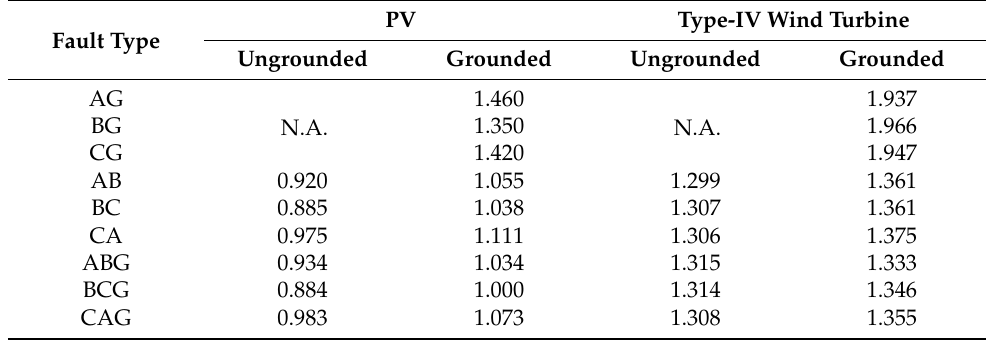
Figure 16. K - factor when AB fault is applied and PV plant is connected: ( a ) voltage dip depth in positive ( Fault deep U1 ) and negative ( Fault deep U2 ) sequences; ( b ) reactive current in each phase ( Ir_Phase A , Ir_Phase B and Ir_Phase C ) calculated without consider the maximum current limit of the power converter; ( c ) limitation flag; ( d ) K - factor values; ( e ) reactive current in positive ( I1r ) and negative ( I2r ) sequences; ( f ) Active current in positive sequence; ( g ) phase current; ( h ) reactive current injected in each phase considering the maximum reactive current injection limitation ( Max_Ir ). Table 4. K - factor values when strategy B is applied for negative current